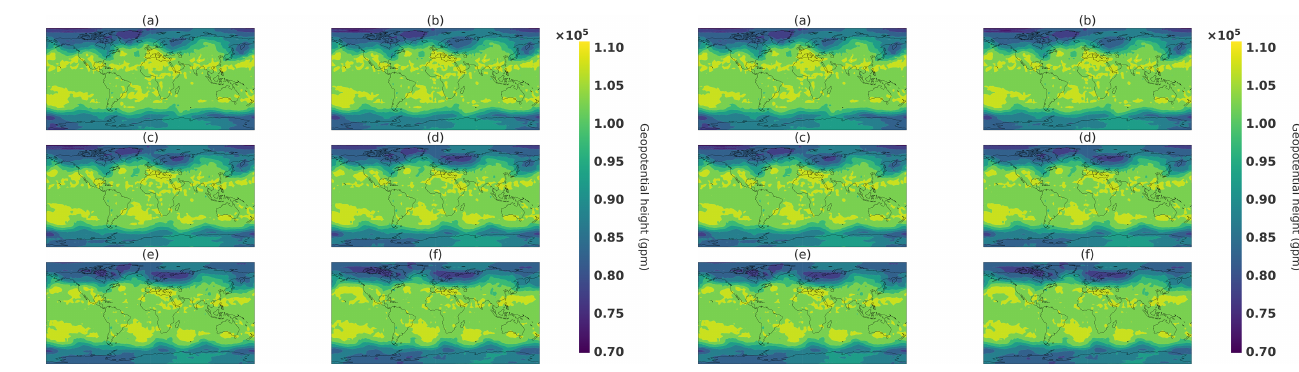
Figure 26. Spherical interpolation snapshots. Respectively, pan- els (a–f) correspond to values of t in Eq. (18) of 0, 0.2, 0.4, 0.6, 0.8, and 1.